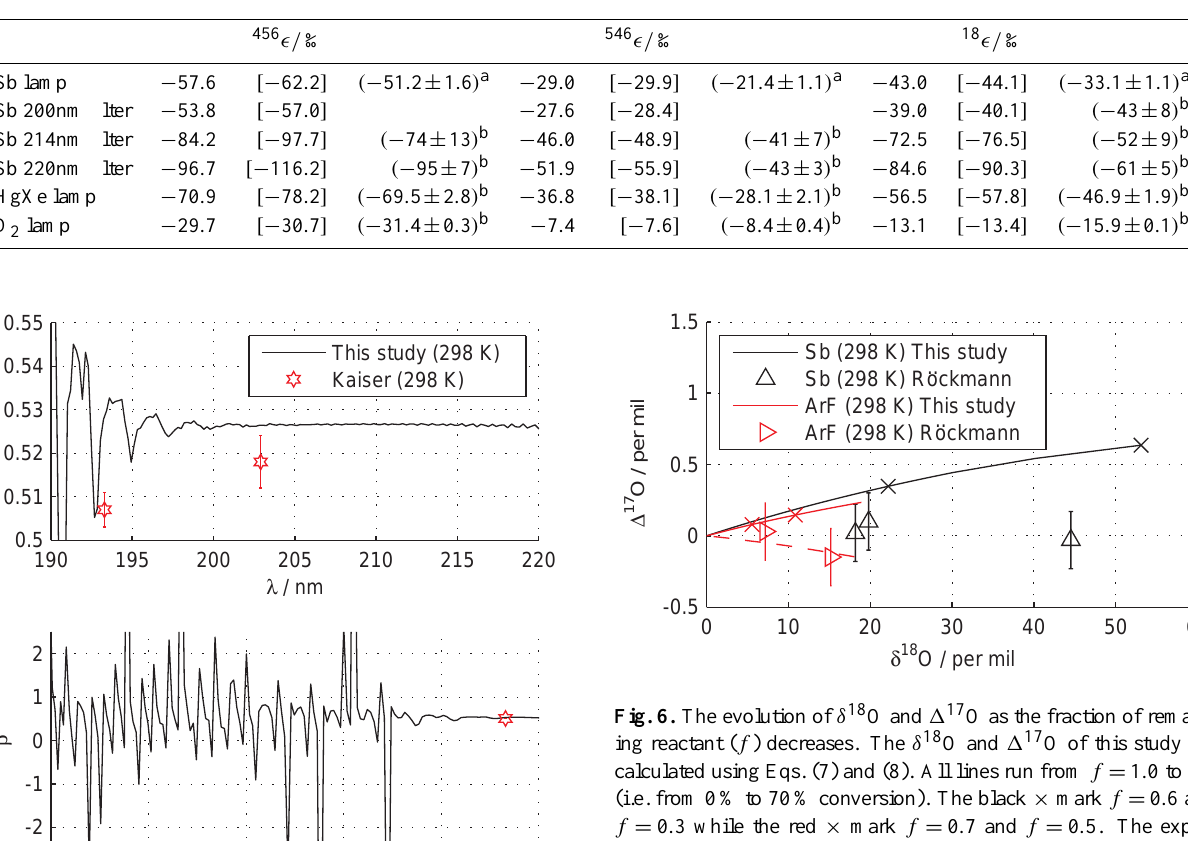
Table 3. Fractionation constants for photolysis with broadband light sources. Results obtained without including ( 0 , 3 , 0 ) and ( 1 , 1 , 0 ) are given in brackets and experimental results of R¨ockmann et al. (2001a) a and Kaiser et al. (2003) b are given in parenthesis.